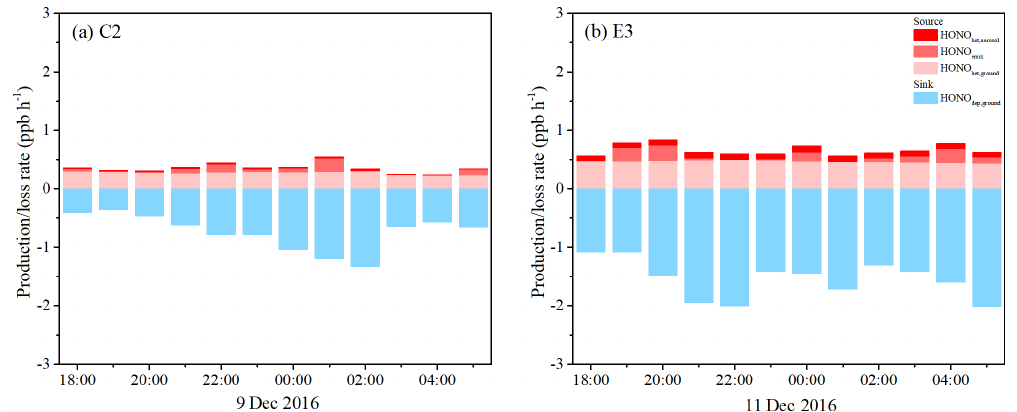
Figure 11. Separated contributions of production and loss terms (colored bars) of HONO on (a) 9 December 2016 (C2) and (b) 11 Decem- ber 2016